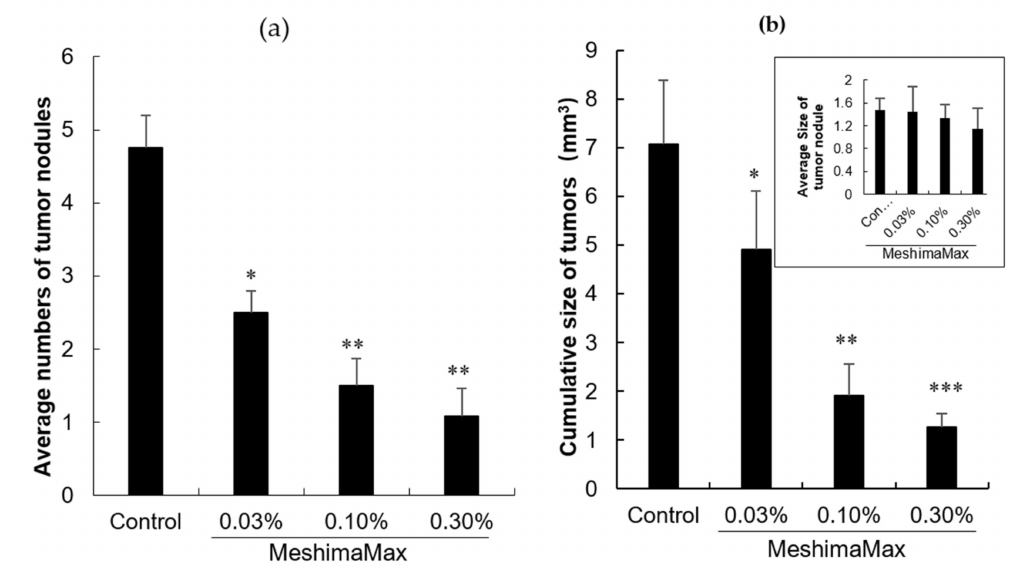
Figure 1. Inhibitory e ff ect of MeshimaMax on the tumorigenesis in mice treated by azoxymethane (AOM) / dextransulfatesodium(DSS).( a )Averagenumbersoftumornodulesinthecolon; ( b )Cumulative size of tumor nodules in each mouse. Inset of (b) shows the average size of tumor nodules developed in the colon of mice. * P < 0.05; ** P < 0.01; *** P < 0.001 vs Control. Data are mean ± SD, n = 6–8.